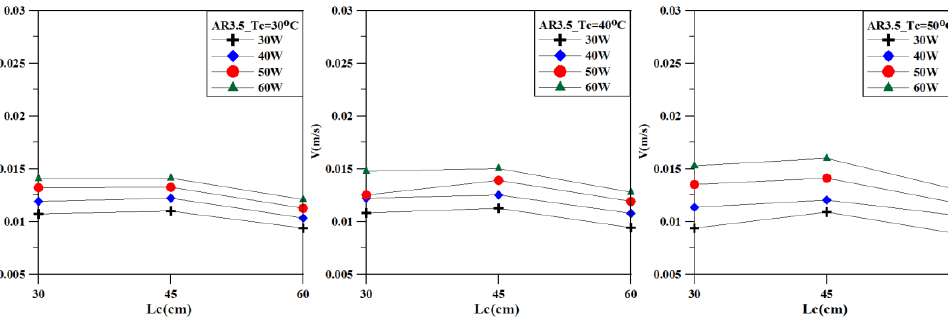
Figure 7. The relationship between the average fluid velocity and the length of the cooling end Lc.